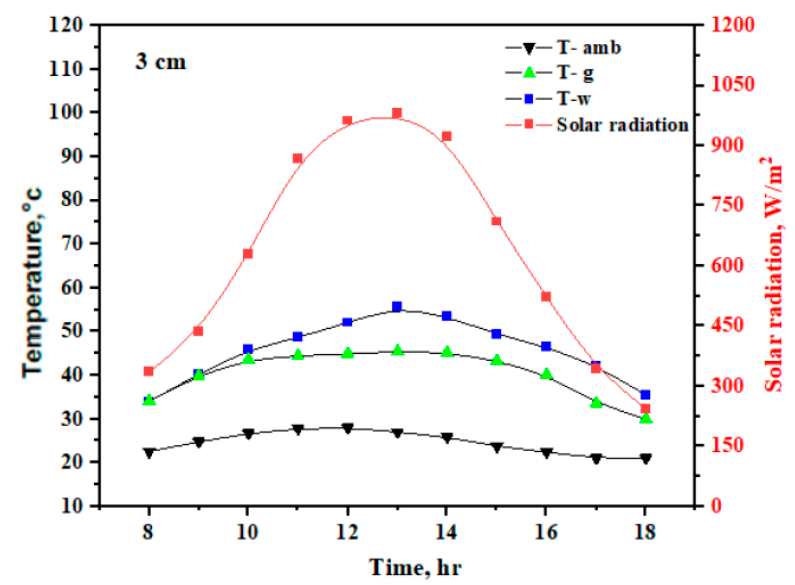
Figure 5. Daily variations of temperature and solar intensity of the still with 3 cm water depth. The daily variations of the basin’s water temperature of the still with a water depth ranging from 1 to 3 cm are plotted in Figure 6. From 8:00 a.m. to 14:00 p.m., the water temperature in the basin is higher at 1 cm than it is at 2 and 3 cm, and then it gradually drops. Rising the water depth from 1 to 2 cm caused a decrease in the basin’s water tem- perature of up to 4% (from 8:00 a.m. to 14:00 p.m.), and an increase of up to 2% (from 15:00 p.m. to 18:00 p.m.), which has a direct impact on the energy, exergy, and water produc- tivity. Whereas raising the water depth to 3 cm caused a decrease in the basin’s water temperature of up to 9% (from 8:00 a.m. to 14:00 p.m.), and an increase of up to 3.5% (from 15:00 p.m. to 18:00 p.m.). This increase in the basin’s water temperature is due to the en- ergy-storing ability of the water held in the basin. Figure 6. Daily variations of water temperature with respect to time. The heat and mass transfer (inside the still) are largely affected by the water depth and basin water temperature depending on Equations (3)–(8). The daily variations in the heat transfer coefficients by convection and evapora- tion inside the still are depicted in Figures 7 and 8. As seen from the figures, at various water depths